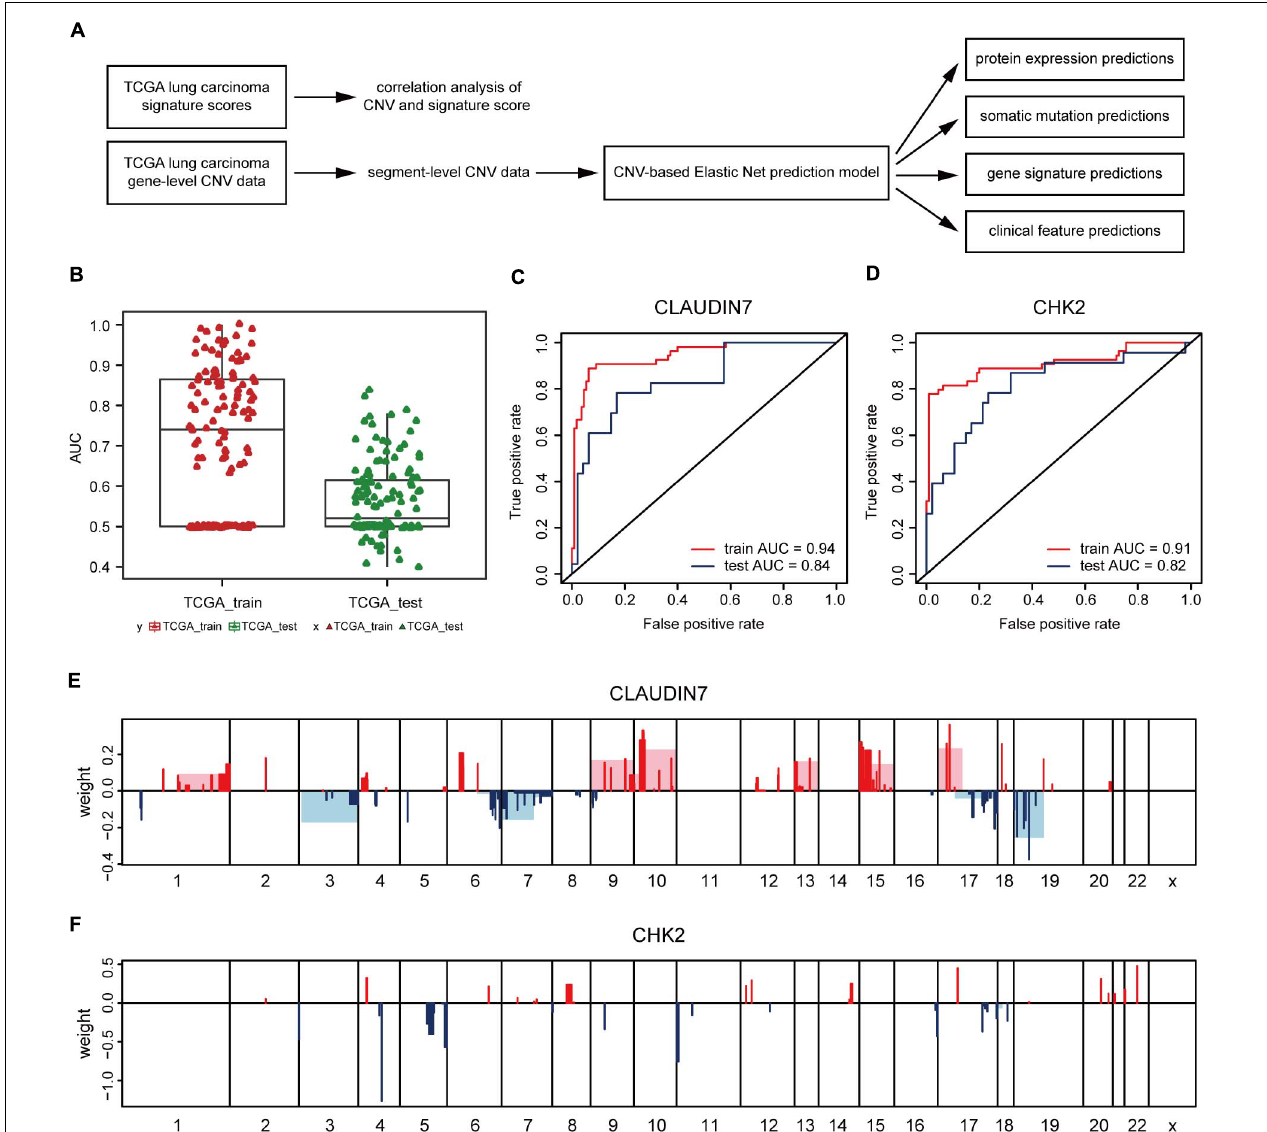
FIGURE 3 | CNV-based protein expression prediction. (A) Flowchart showed the construction of CNV-based Elastic Net prediction models and the certification of its predictive value on gene expression, protein, mutation and clinical features. (B) AUC distributions of CNV-based expression level predictions for 131 proteins in the RPPA arrays. (C,D) ROC curves and corresponding AUC values of Claudin7 (C) and CHK2 (D) in the TCGA training and test sets. (E,F) Elastic Net-selected CNV segments and whole chromosomal arms and their coefficients for prediction models for the two proteins.